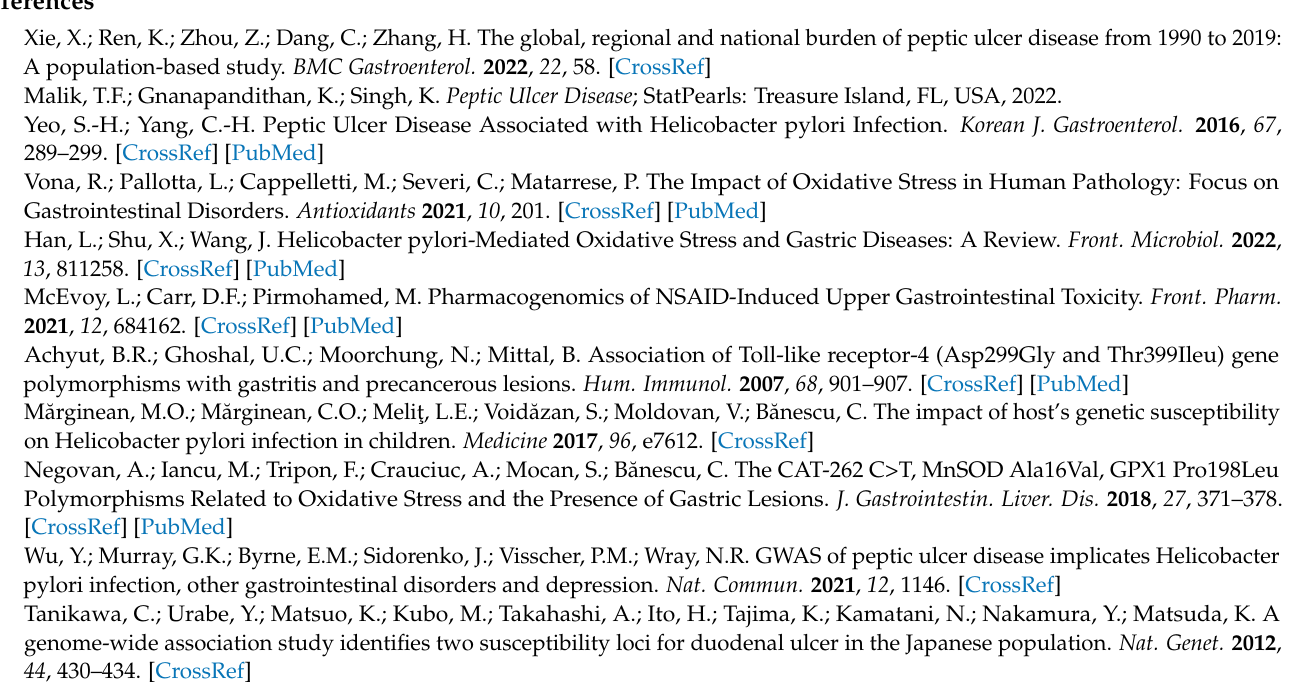
Table S2. The adjusted odds ratio of polygenic risk scores with duodenal ulcer risk. Figure S1. The root mean square deviation (RMSD) and root mean square fluctuations (RMSF) of azaspiracid 2 (A and B) in wild-type and RMSD and RMSF of azaspiracid 2 (C and D) in mutated CD6 rs11230563 (R225W) during molecular dynamic